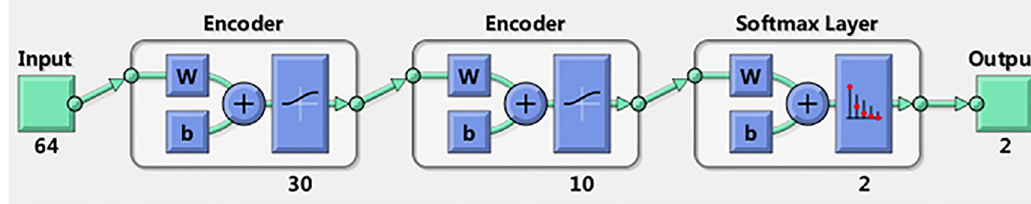
Fig 8. The architecture of the classification model used in this work.